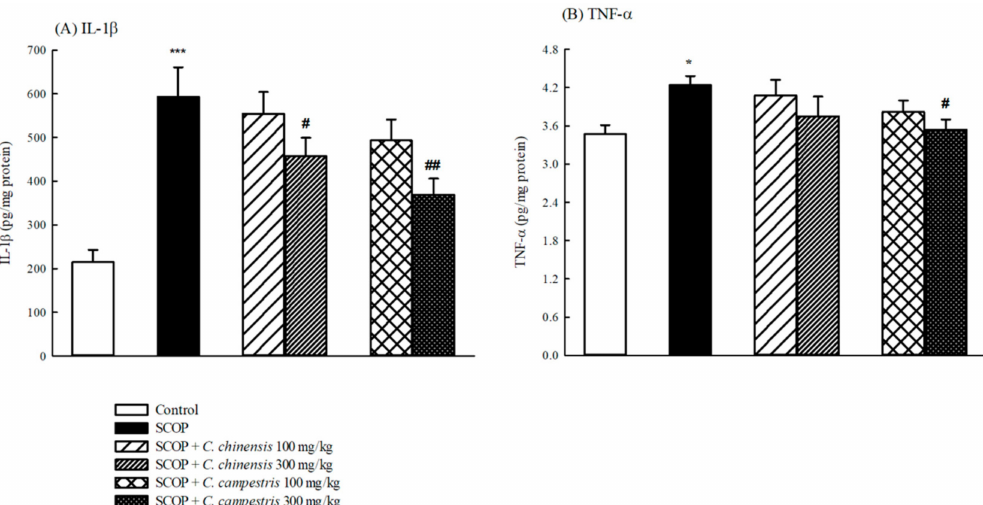
Figure 7. The effects of the Cuscuta chinensis and C. campestris extracts (100 and 300 mg/kg, po) on ( A ) brain interleukin-1 β (IL-1 β ) levels and ( B ) brain tumor necrosis factor α (TNF- α ) levels in scopolamine (SCOP, 1 mg/kg, ip)-treated mice. All the brain tissues were collected from the tested mice and then homogenized to obtain the total brain homogenates. The IL-1 β and TNF- α levels in the total brain homogenates were subsequently examined. Columns indicate mean ± SEM ( n = 7). * p < 0.05, *** p < 0.001 compared with the control group. # p < 0.05, ## p < 0.01 compared with the SCOP group.